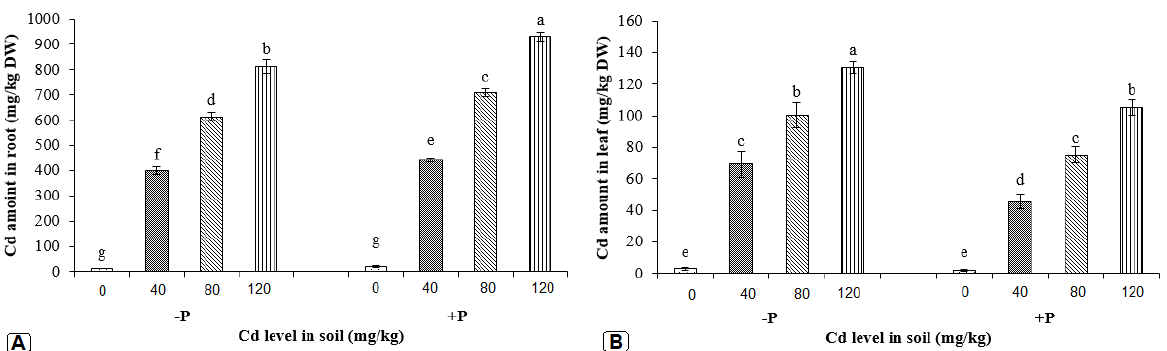
Fig. 4. The effect of P. indica on A) root Cd and B) leaf Cd accumulation in sunflower under different Cd concentrations in soil. P: P. indica. Values are mean ± SD; n = 5. The same letter within each column indicates no significant difference among treatments using Duncan’s Multiple Range Test at P < 0.05.